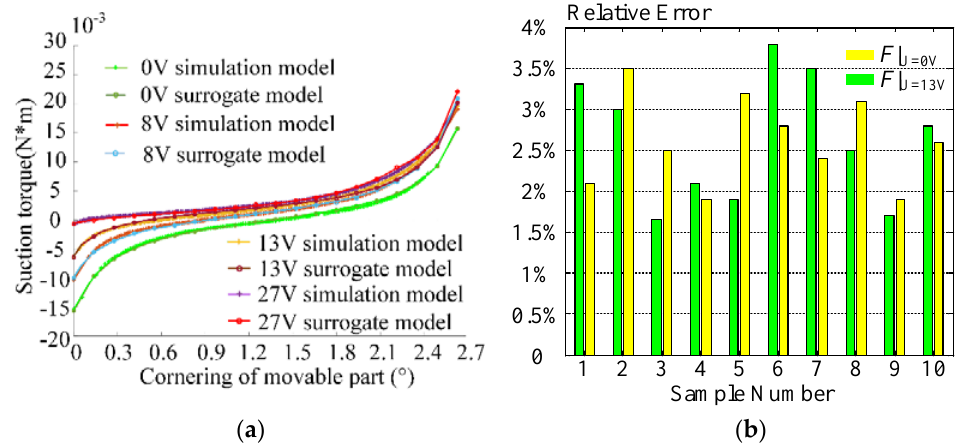
Figure 12. The comparison of the surrogate model with the simulation model: ( a ) static output characteristics (suction torque); ( b ) dynamic output characteristics (operation voltage and operation time). Table 4. Fault pattern and related parameters. (“ ↑ ” means increase, “ ↓ ” means decrease).